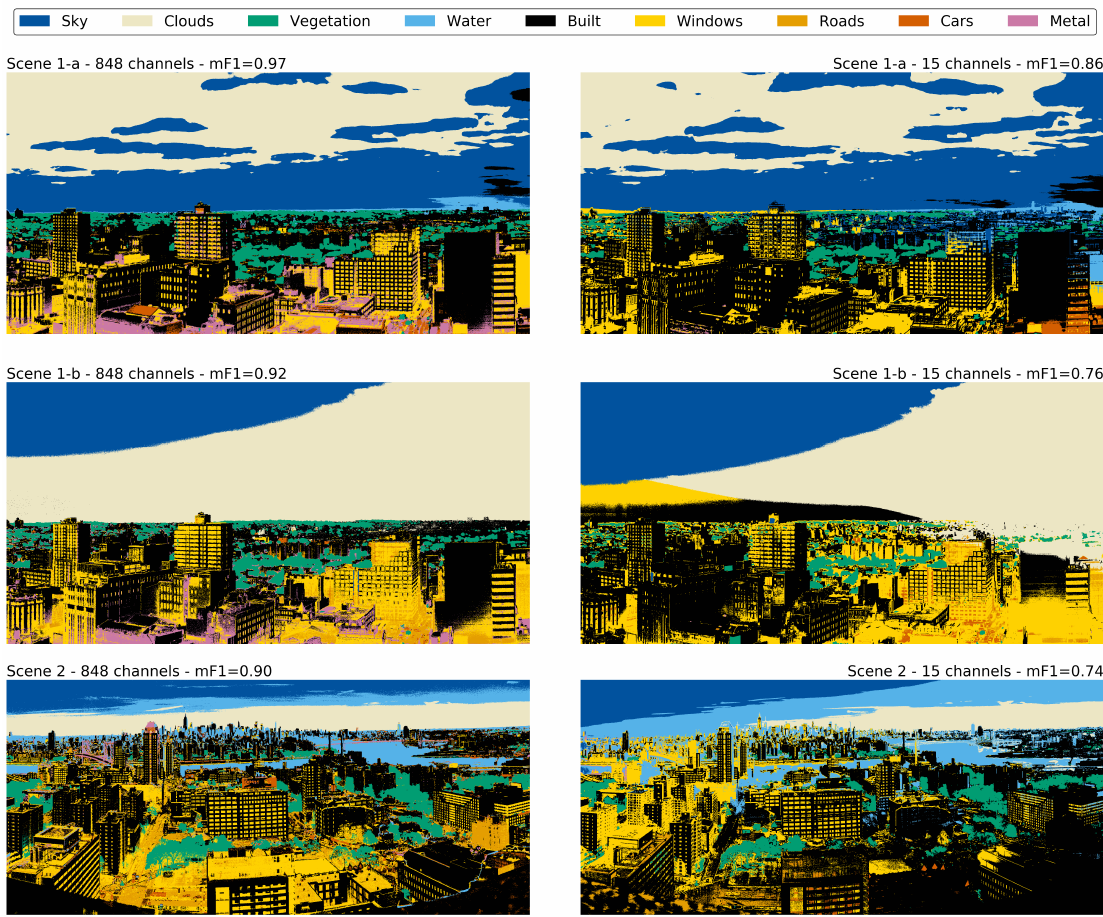
Figure 11. Image segmentation results from Model 2 trained and tested on Scene 1-a ( middle ), Scene 1-b ( center ), and Scene 2 ( bottom ), with the HSIs at full spectral resolution of 848 channels ( left ) as opposed to those at minimum spectral resolution of 15 channels ( right ). Qualitative inspection shows that the model with full spectral resolution outperformed that with reduced spectral resolution in all three scenes. The difference in performance is more pronounced in Scenes 1-b and 2 than in Scene 1-a. Identification of Vegetation pixels stands out as the only class in all images to be unaffected by the decrease in spectral